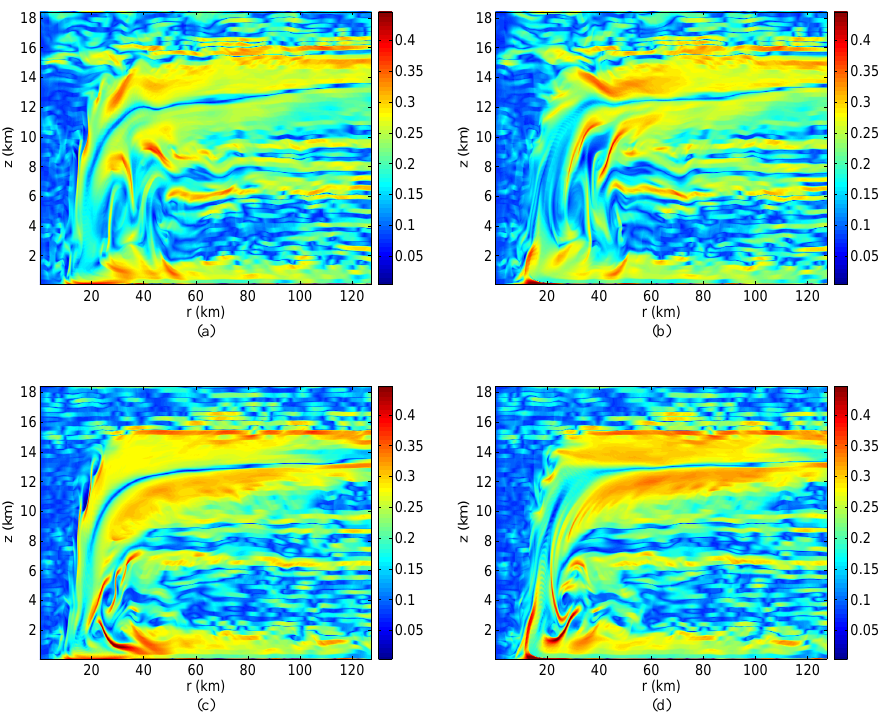
Fig. 10. Weak composite forward (a) and backward (b) FTLE fields, and strong composite forward (c) and backward (d) FTLE fields, integrated for 20 minutes. where the mixing rate value is assigned to the initial time of integration.